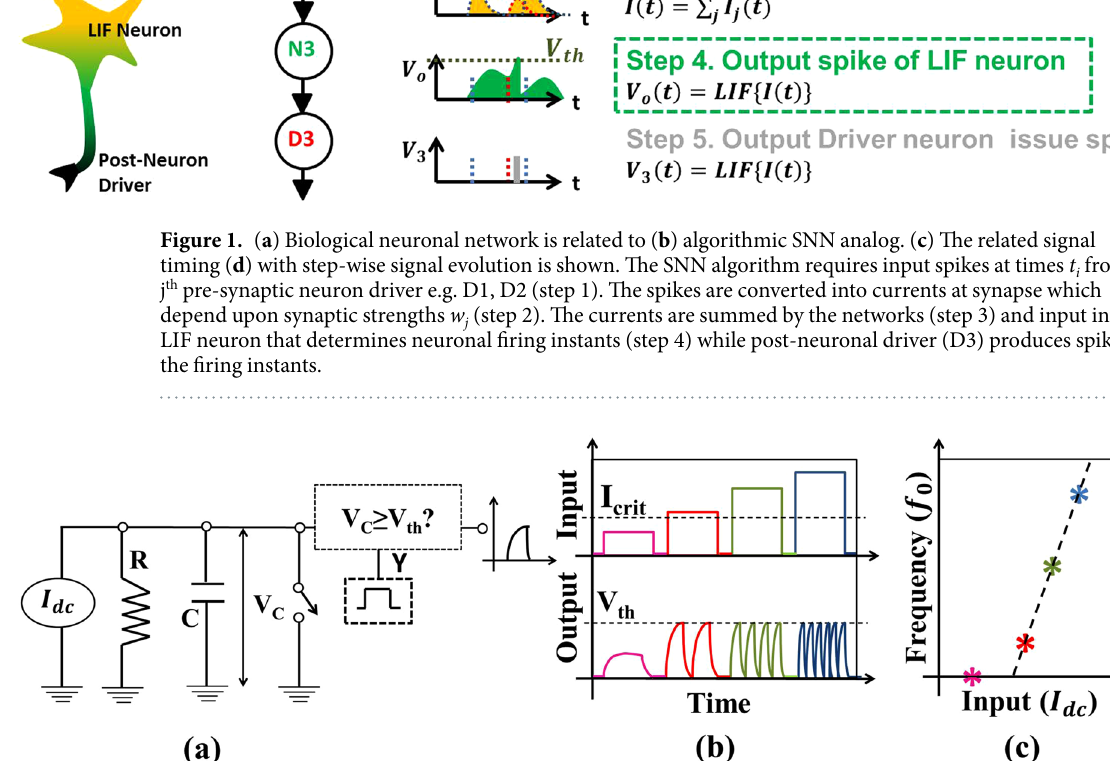
models, the leaky integrate and fire (LIF) model can mimic the behavior of the biological neuron with minimum number of circuit element unlike other models 11–13 . LIF Neuron Model.